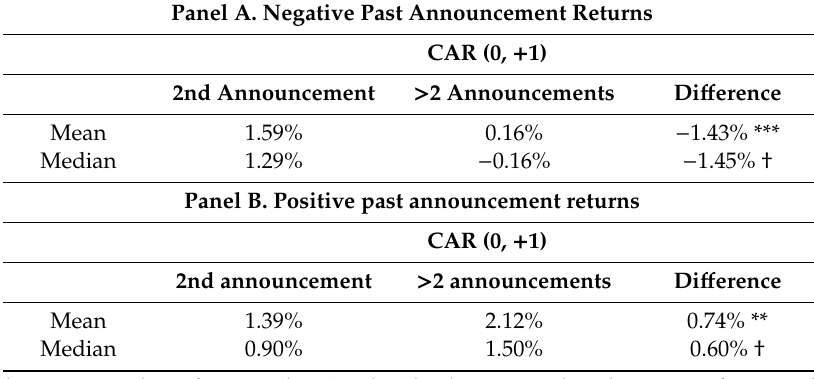
Table 4. Announcement returns sorted by past announcement